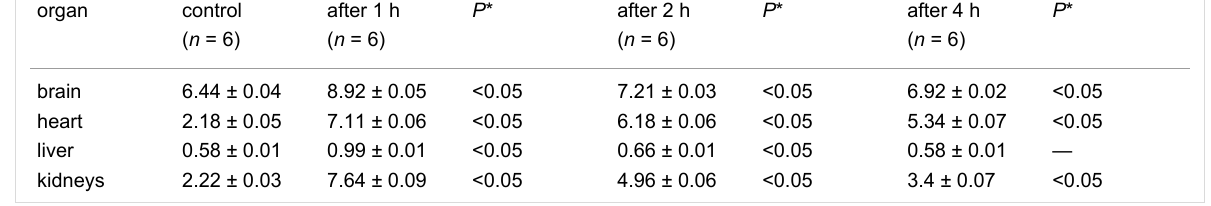
Table 1: Concentration (nM/mg) of lipid peroxides measured after administration of PEGylated nano-graphene oxide in different organs after different periods of time (mean ± standard deviation). organ